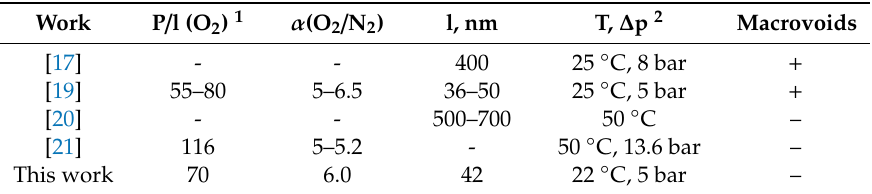
Table 2. The comparison of obtained results with the literature data.